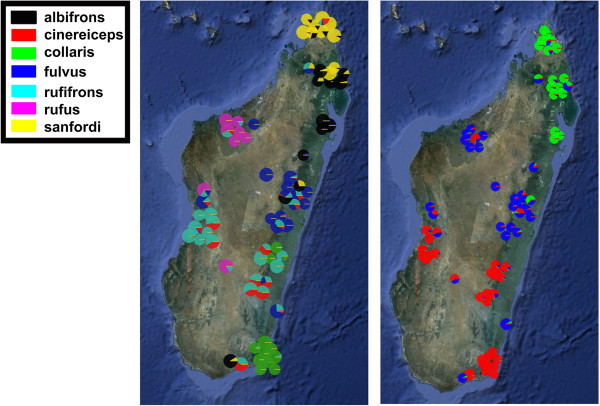
Geographic plot of nuclear genetic population structure of species of the brown lemur complex as inferred by Markolf et al. [24] using STRUCTURE (K = 3) and Discriminant Analysis of Principal Components (DAPC). Pies represent individuals. Colors represent assignment probabilities of individuals to populations (STRUCTURE, left) or species (DAPC, right). Species colors for the DAPC analysis are given in the color legend. Please note that the color legend is only relevant for the map on the right. Pies correspond only roughly to the sampling locality.